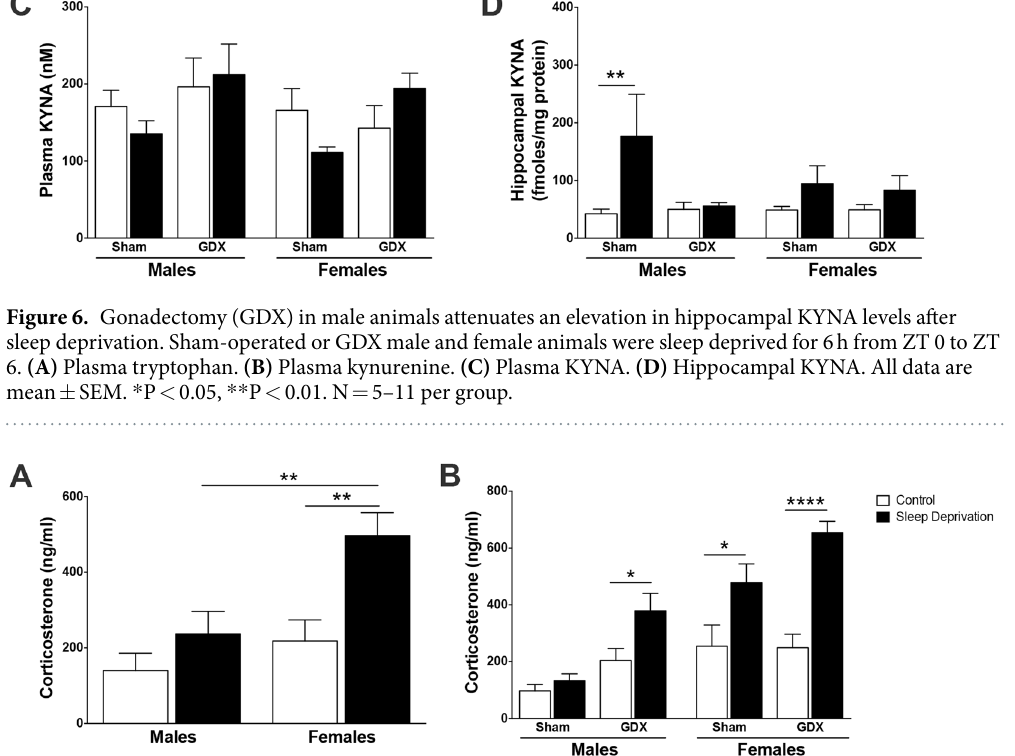
Male gonadectomy attenuates hippocampal KYNA elevation in response to sleep deprivation. Next, we assessed hippocampal KYNA levels in response to sleep deprivation in gonadectomized rats (Fig. 6D). No three-way interaction between sleep condition, sex, and surgery (F 1,63 = 2.1, P = 0.15) was determined for hippocampal KYNA. Additionally, no significant two-way interactions were determined (sleep x sex: F 1,63 = 0.6, P = 0.46; sleep x surgery: F 1,63 = 3.0, P = 0.09; sex x surgery: F 1,63 = 1.6, P = 0.46). There was a significant main effect of sleep condition (F 1,63 = 7.4, P < 0.01), but no main effect of sex (F 1,63 = 0.4, P = 0.55) or surgery (F 1,63 = 2.4, P = 0.13). Sham sleep-deprived males had significantly more hippocampal KYNA than sham control males, but KYNA levels were not significantly different between control GDX males and sleep-deprived GDX males. KYNA remained unchanged after sleep deprivation in both sham and GDX females. Sleep deprivation by gentle handling dimorphically elevates plasma corticosterone in male and female rats. Due to the distinct behavioral and KP biochemical outcomes in male and female rats, we examined the stress response hormone corticosterone in the plasma after sleep deprivation. In the intact cohort, plasma corticosterone was significantly impacted by sleep condition (F 1,32 = 11.4, P < 0.01) and sex (F 1,32 = 9.2, P < 0.01) (Fig. 7A). Corticosterone was elevated by 130% in sleep-deprived females compared to control females. Male animals, however, did not have significantly higher corticosterone after sleep deprivation. To determine whether gonadal hormones play a role in the observed differential response in circulating cor- ticosterone, sleep deprivation experiments were conducted in the gonadectomized cohort of adult male and